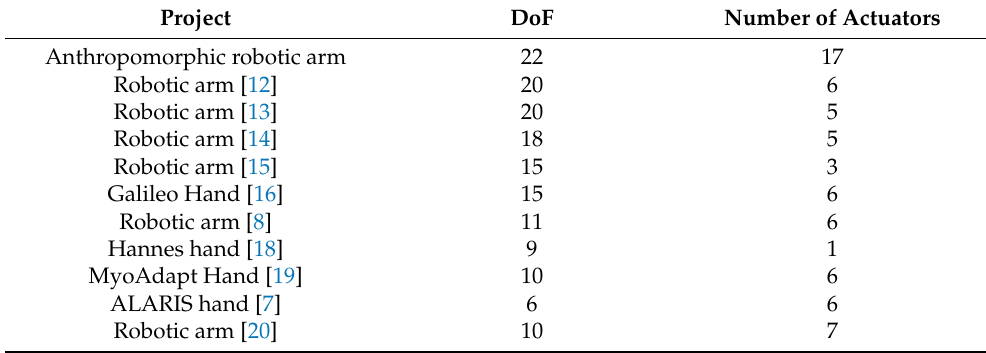
Table 1. The comparison of the main parameters of some modern designs of robotic arms.